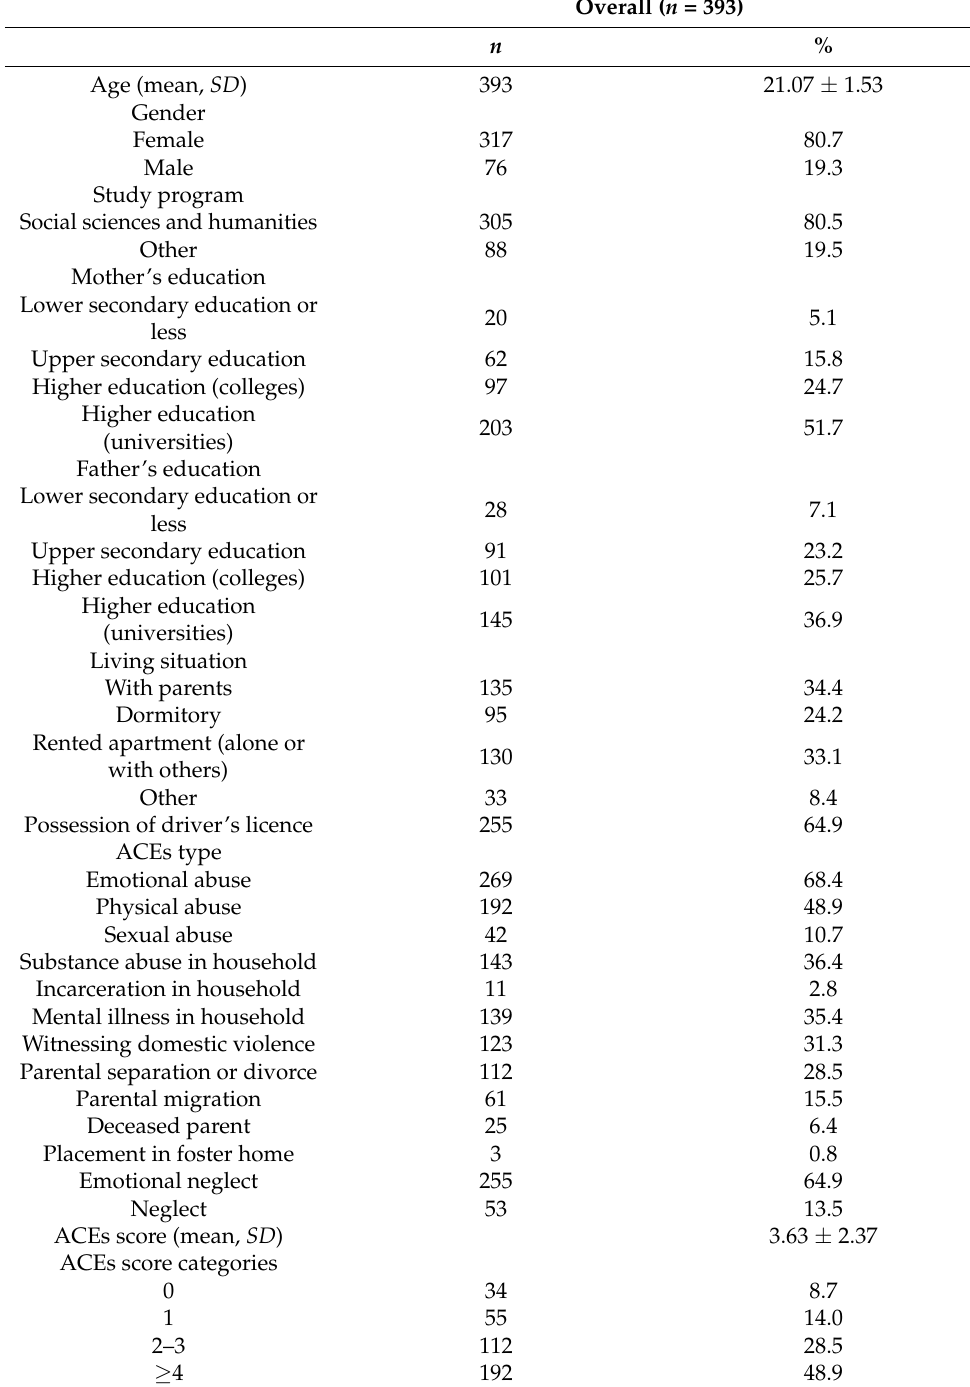
Table 1. Participant demographic characteristics and descriptive statistics of adverse childhood experiences